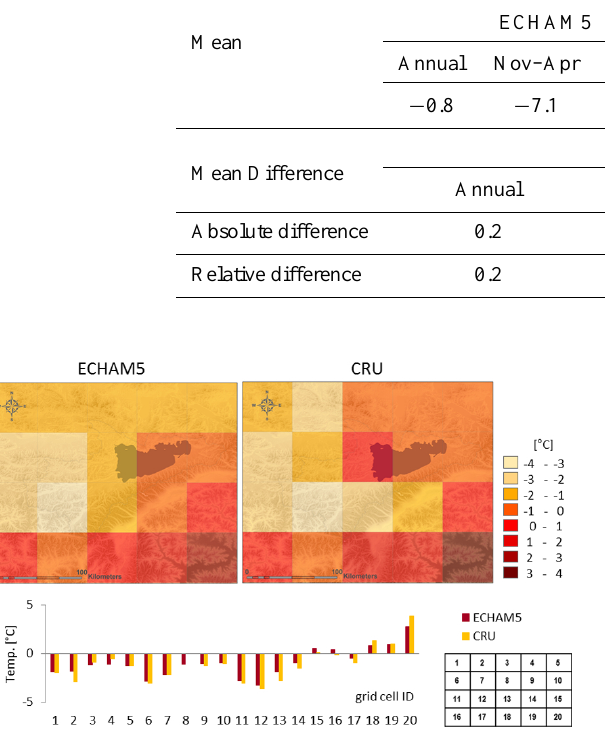
Fig. 2. Comparison of annual mean temperature data of ECHAM5 and CRU for the period 1981–2004.